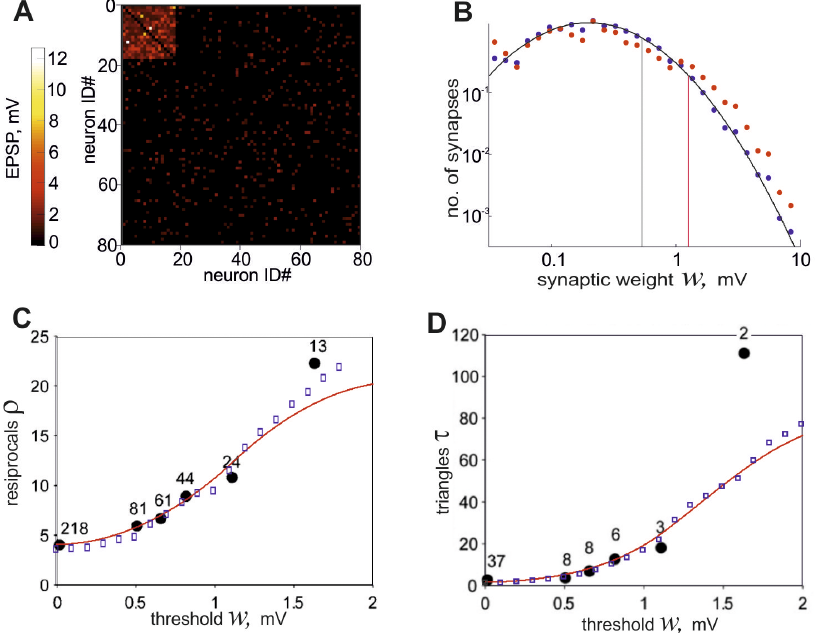
Figure 2. The properties of the network generated by the developed algorithm. A , An example of connectivity matrix for 80 excitatory neurons containing a single cluster is shown. The weight of each connection is presented in pseudo color. B , The probability density of nonzero weights distribution is shown in logarithmic scales. Black circles show the weight distribution obtained for the entire network and red circles show the distribution inside the cluster. Solid curve represents a lognormal fit to the data points, black vertical line corresponds to the mean weight of connections for the entire network and red line corresponds to the mean weight inside the cluster. C , The coefficients of the overrepresentation of reciprocal connections r versus threshold value w are shown. Blue squares are obtained in the model network and black circles are taken from the experimental data shown in ref. [10], where each number shows the number of the corresponding connections obtained by experiment. Red line is calculated by formula (7) for the parameter choice of K =1. D , The coefficients of the overrepresentation of triangles t ( w ) are shown. Symbols are used in the same manner as in the previous plot.